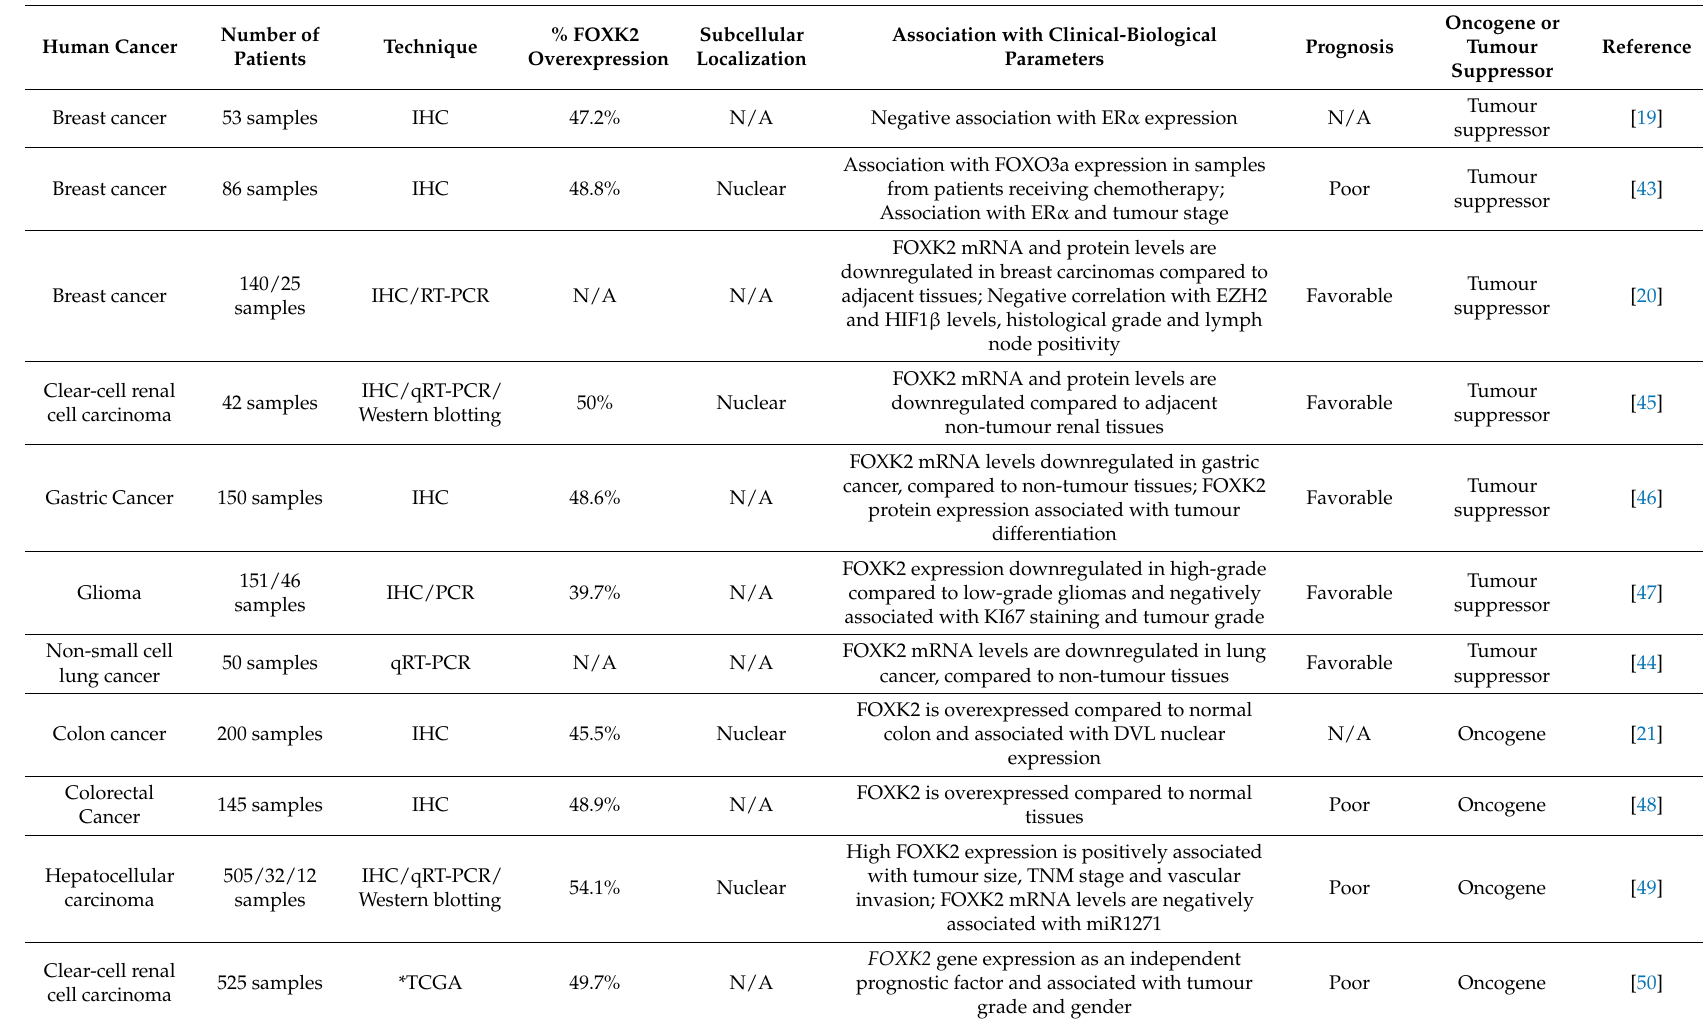
Table 3. FOXK2 expression in samples from cancer